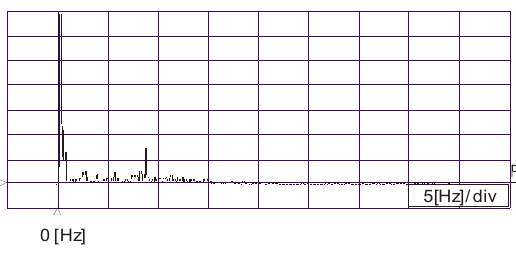
Figure 20. Turbulent high wind speed and pitch angle control: ( a ) Wind speed, ( b ) generator speed, ( c ) generator power, ( d ) q-axis current, and ( e ) and generator torque.